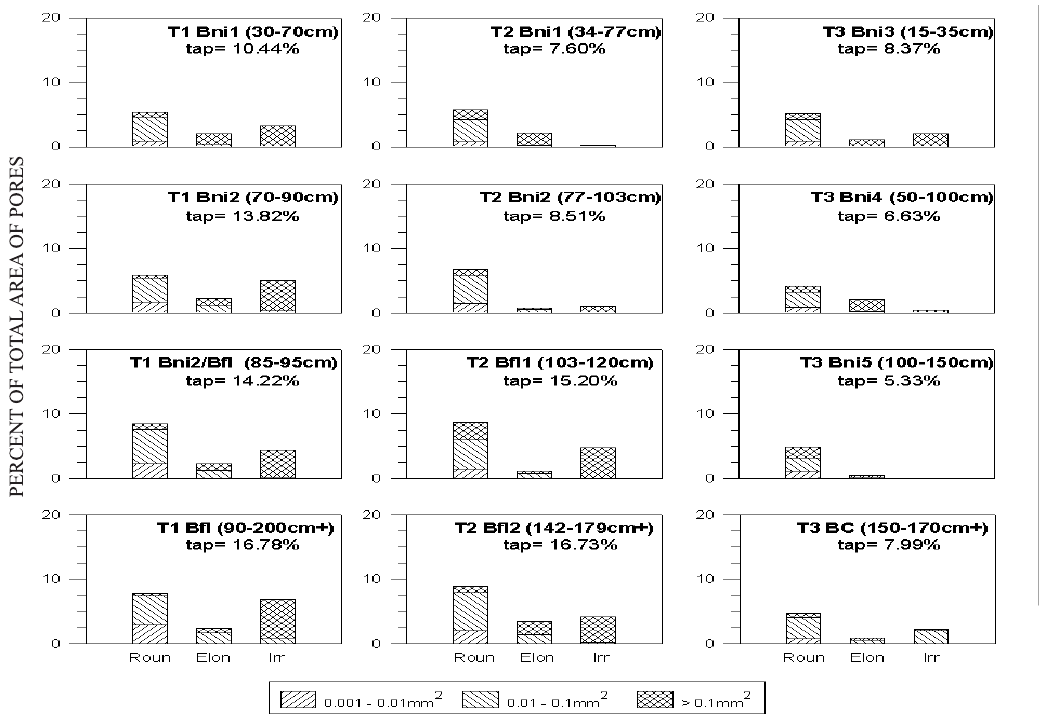
Figure 4. Pore distribution according to area and